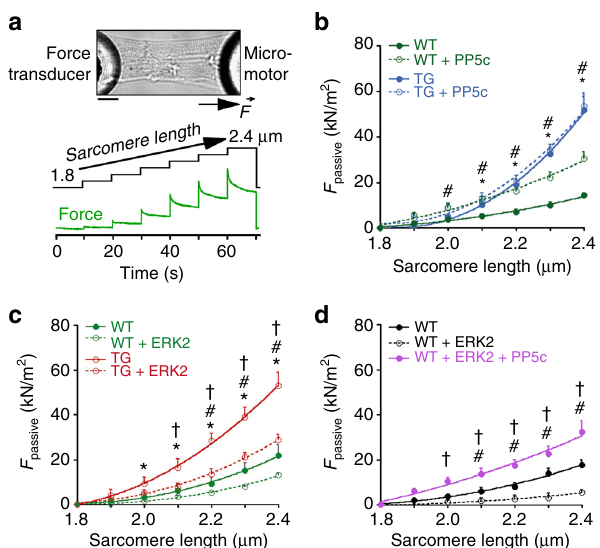
Fig. 6 Binary interactions of PP5 or N2Bus and role of Hsp90. a Interactions of PP5 or PP5c by GST-pulldown assay. The PP5-GST assay is a negative control. b Interactions of N2Bus by GST-pulldown assay. c Impact of Hsp90 on PP5-N2Bus binding in GST-pulldown ‘ competition ’ assays. ‘ PP5 → Hsp90 ’ : N2Bus immobilized on GSH-beads, incubated with PP5, then washed, and Hsp90 added thereafter. ‘ Hsp90 → PP5 ’ : N2Bus immobilized on GSH-beads, incubated with Hsp90, then washed, and PP5 added thereafter. Summary data in bar graph are relative values indexed to the ‘ PP5 → Hsp90 ’ condition; mean ± s.e.m., n = 5 experiments/condition; * p < 0.05, by two-tailed Student ’ s t -test. d Localization of Hsp90 in cardiomyocytes from PP5 TG and WT hearts by indirect